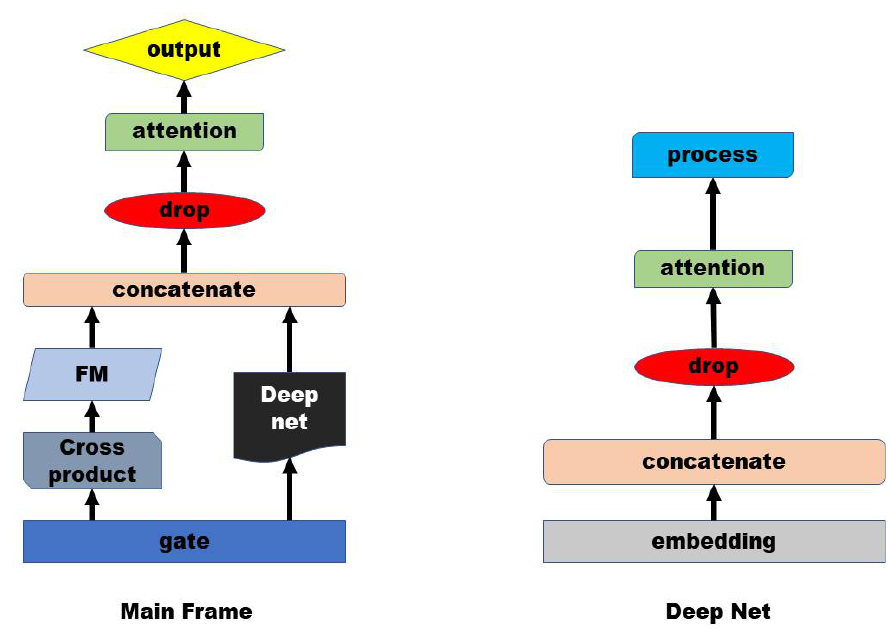
Figure 2. Main framework of the GAFM.